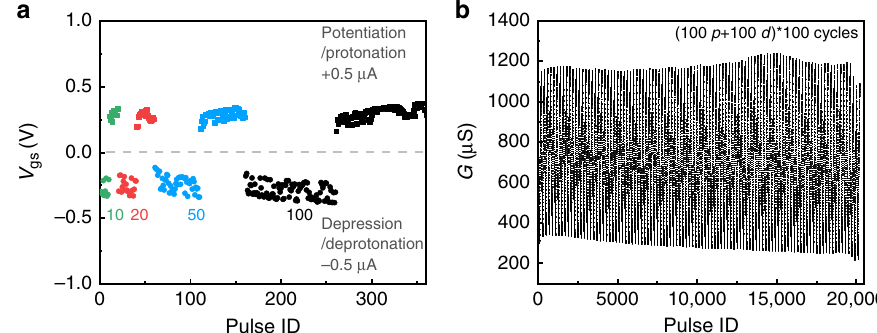
Fig. 3 Gate voltage restulting from gate current pulses, and retention of multistate capability upon cycling. a Average potentiation/depression voltage, resulting from pulses of ±0.5 µ A and 5 ms, during the operation of the device in the medium conductance regime shown in Fig. 2c. b The retention of multi state capability over 100 cycles of the device, each cycle contains 100 potentiation and 100 depression steps. These data are obtained in the high conductivity regime.